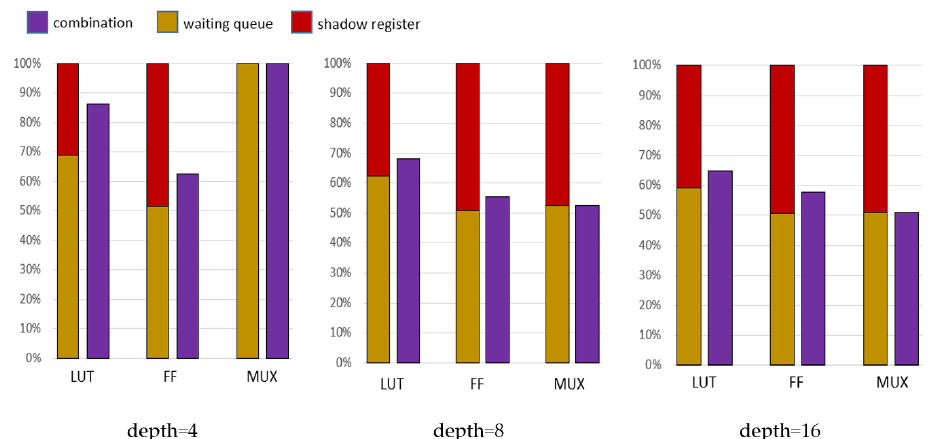
Figure 11. Comparison of hardware resource utilization of the optimizing designs and the combined design with different depths of OITF. Because of reused resources, the combined design consumes less than the individual optimizing designs of the two.